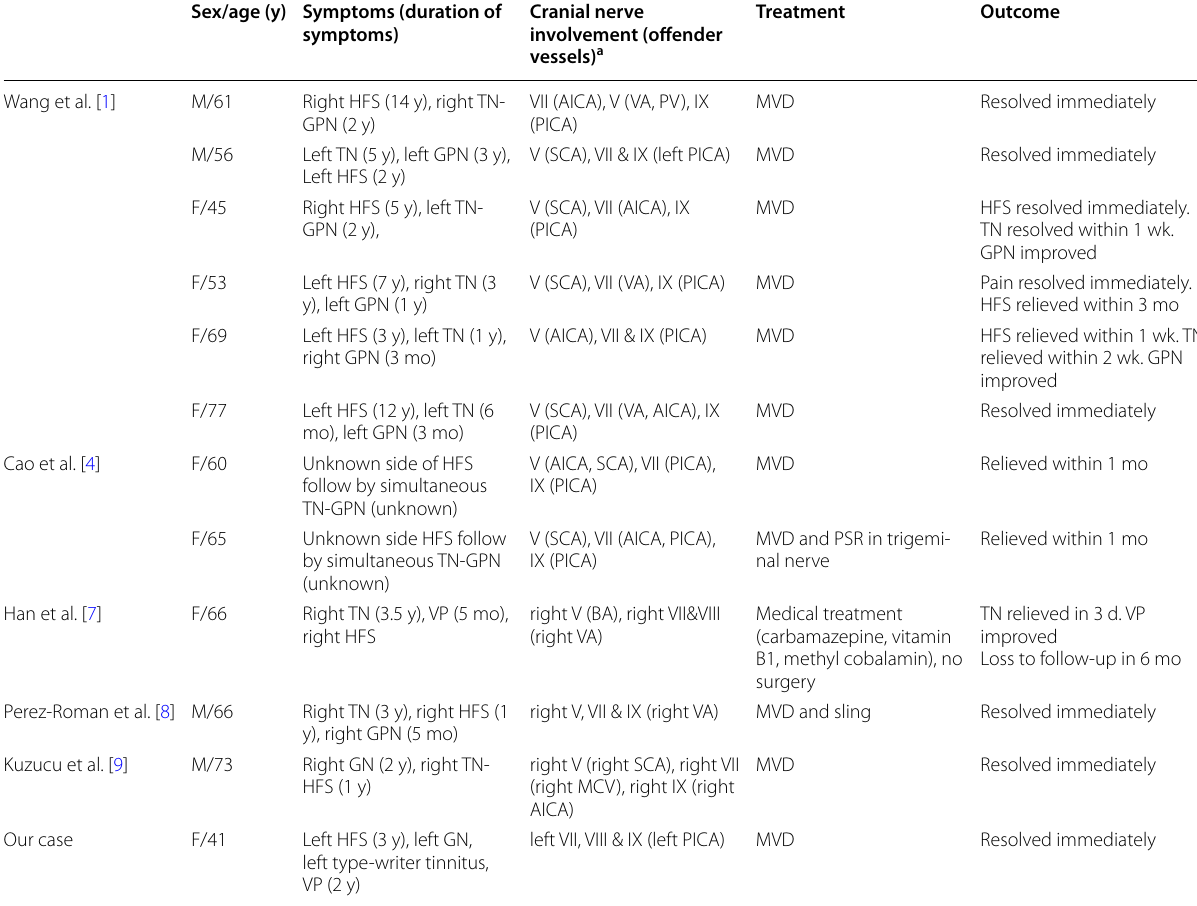
Table 1 Eleven published cases of combined neurovascular compression syndromes with three or more cranial nerves